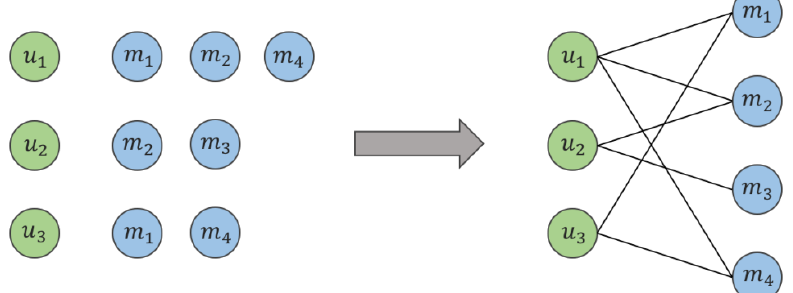
Figure 3. This is an example of a ‘customer–shop’ bipartite graph. The green nodes represent customers, the blue ones are shops, and the edges between the two nodes are the purchasing relationship between customers and shops. For instance, 𝑢 1 is connected to 𝑚 1 , 𝑚 2 , and 𝑚 4 , which means that customer 1 has purchased products in shops 1, 2, and 4.